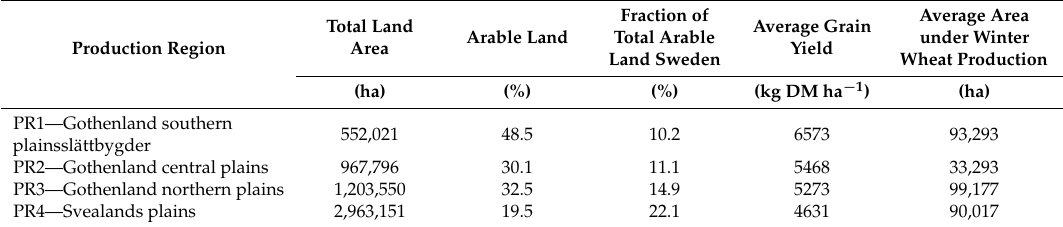
Table 1. Total area, fraction of arable land and standard yields for winter wheat (2012–2016) in the assessed production regions